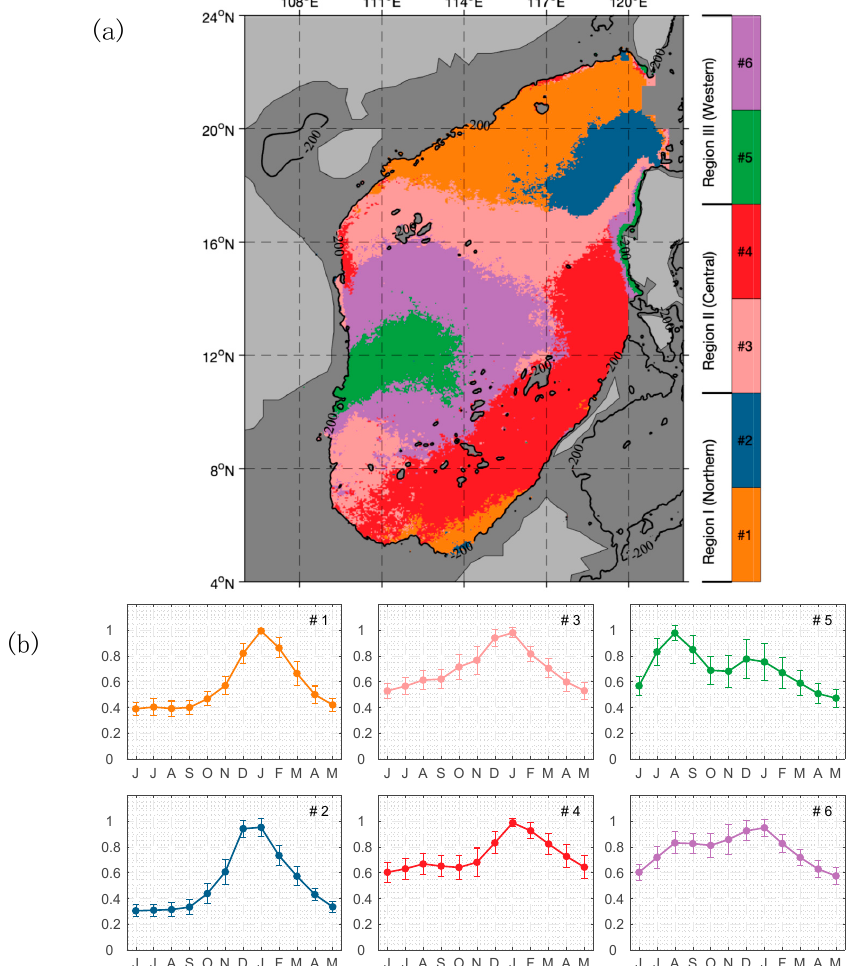
Figure 3. Results of k-means cluster analysis showing ( a ) spatial distribution of the clusters (1–6) and ( b ) temporal evolution of the cluster centers. The black lines in ( a ) show the 200-m isobath. The curve colors in ( b ) correspond to the same color scale in ( a ). Error bars in ( b ) indicate the relative +/ − one standard deviation.